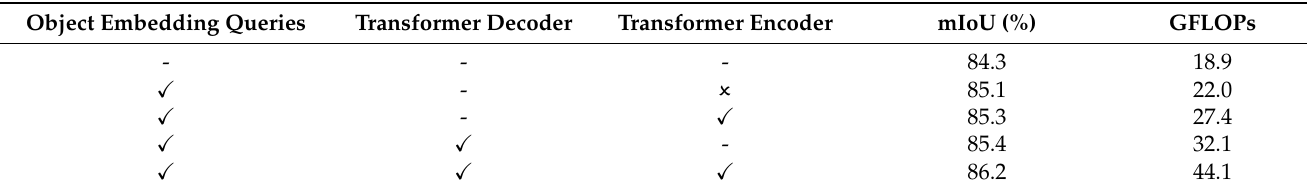
Table 3. Effect of each component in our model.